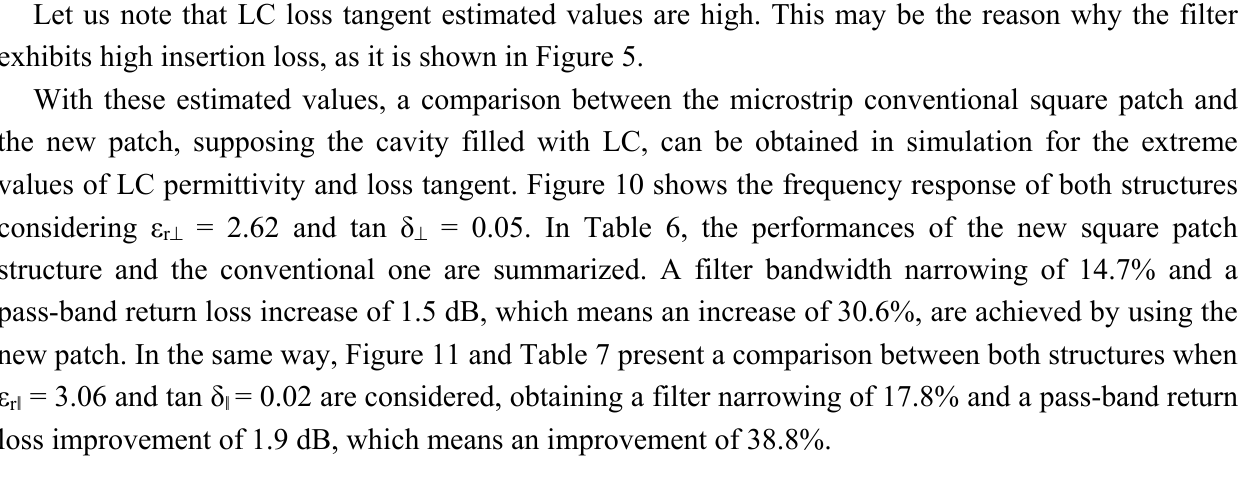
Figure 9. Comparison between the measured frequency response when 15 V and the simulated considering when ε